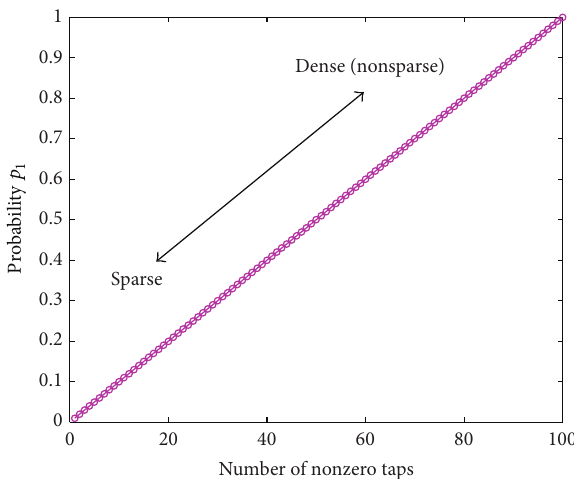
Figure 2: Sparseness of channel vector h depends on the probability 𝑝 1